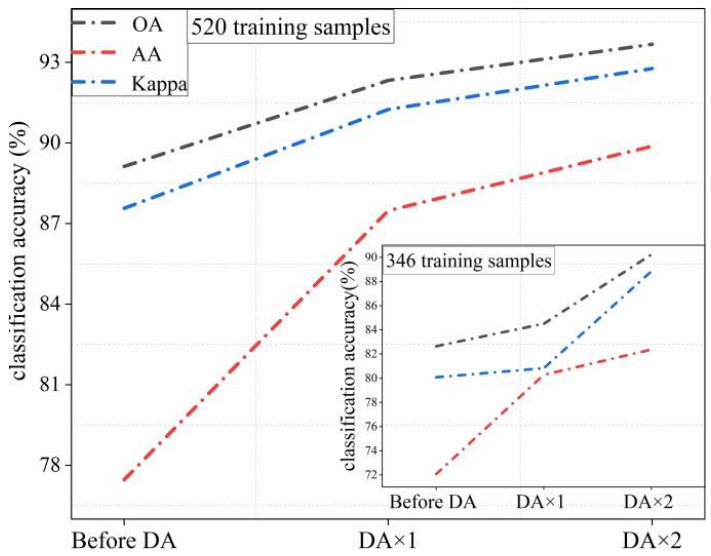
Figure 6. Classification, before and after DA operation, under 346 and 520 training samples. Table 4. The parameter settings of the random multi-graph algorithm on the three datasets. Parameters